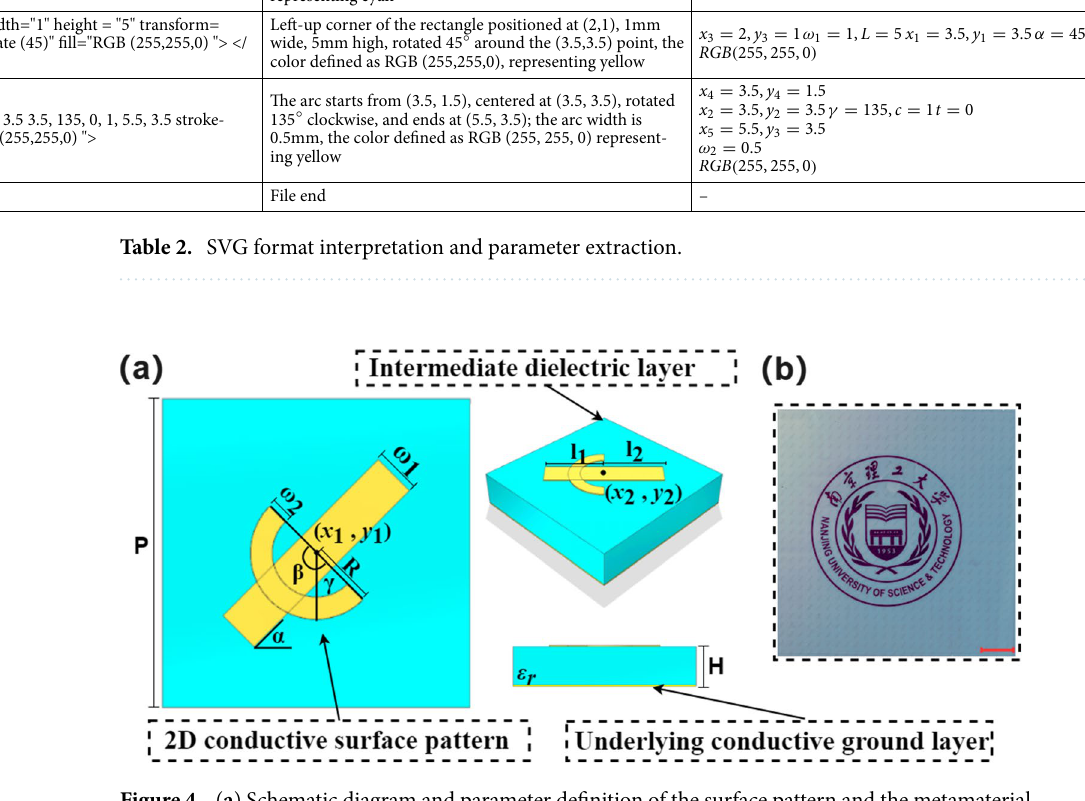
Figure 4. ( a ) Schematic diagram and parameter definition of the surface pattern and the metamaterial. ( b ) Photo of Example 1, on top of a piece of white paper with the university logo printed on it to show the transparency of the sample (scale bar: 2cm).